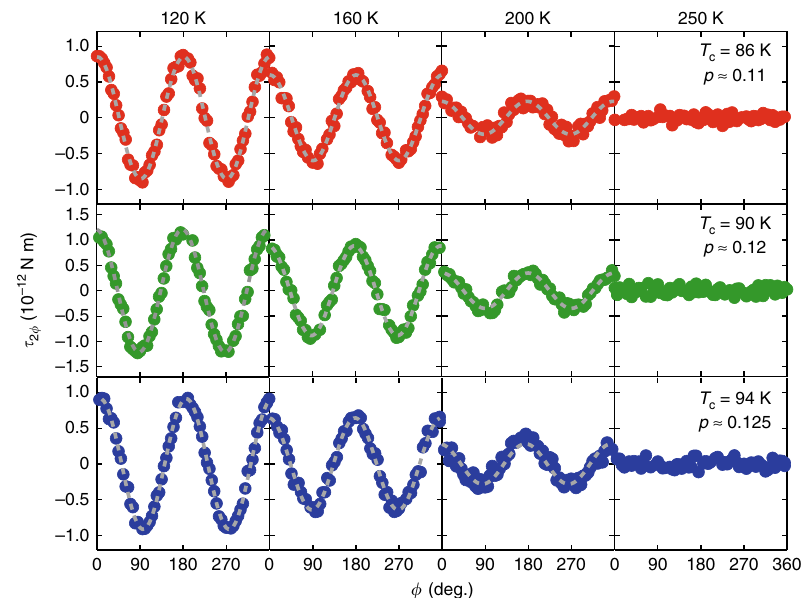
Fig. 3 Twofold oscillations of magnetic torque in the CuO 2 planes. Upper panels show the torque curves τ 2 ϕ as a function of the azimuthal angle ϕ for p ≈ 0.11. Middle and lower panels show τ 2 ϕ for p ≈ 0.12 and 0.125,